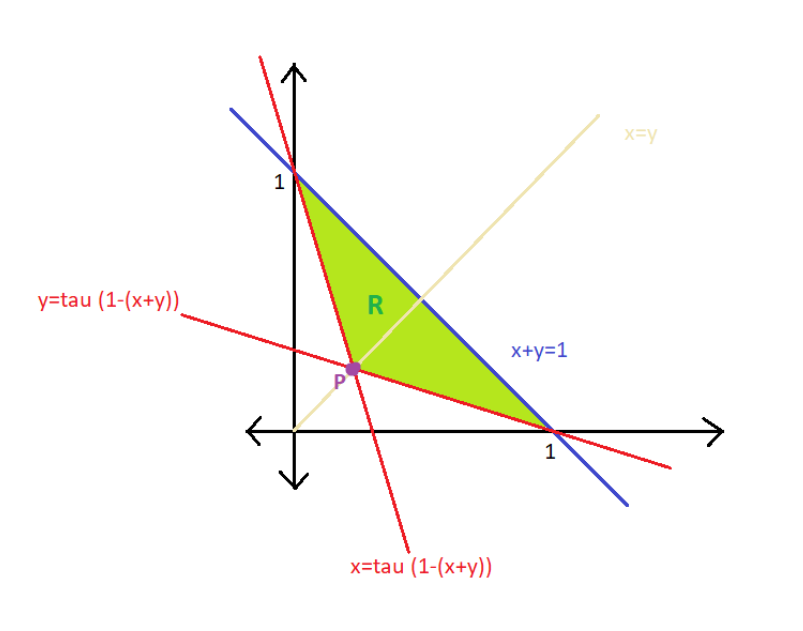
Figure 6. The region R